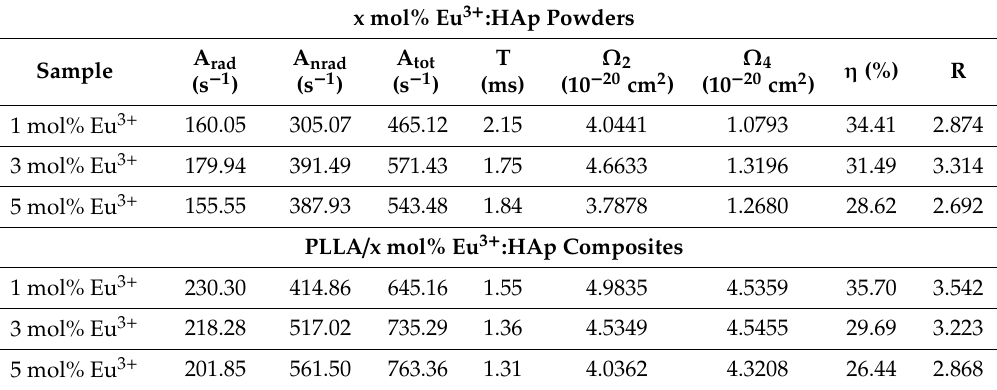
Table 2. Decay rates of radiative (A rad ), non-radiative (A nrad ) and total (A tot ) processes of 5 D 0 → 7 F J transitions, luminescence lifetimes ( τ ), intensity parameters ( Ω 2 , Ω 4 ), quantum efficiency ( η ) and asymmetry ratio (R) of the powders and composites.